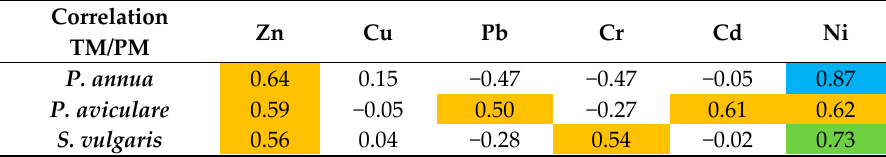
Table 6. Correlation table between PM and TM. Colours indicate the “goodness” of correlation: yellow = significant; orange = relevant; green = high; blue = excellent.